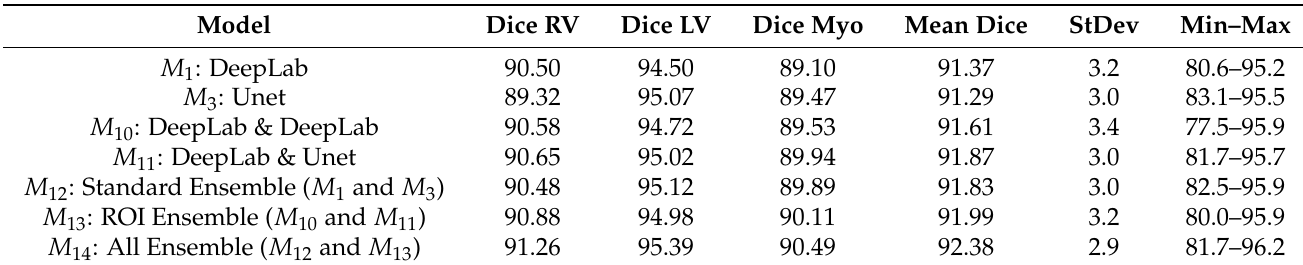
Table 3. Results on the ACDC validation set (RV—right ventricle, LV—left ventricle, Myo—myocardium). Model Dice RV Dice LV Dice Myo Mean Dice StDev